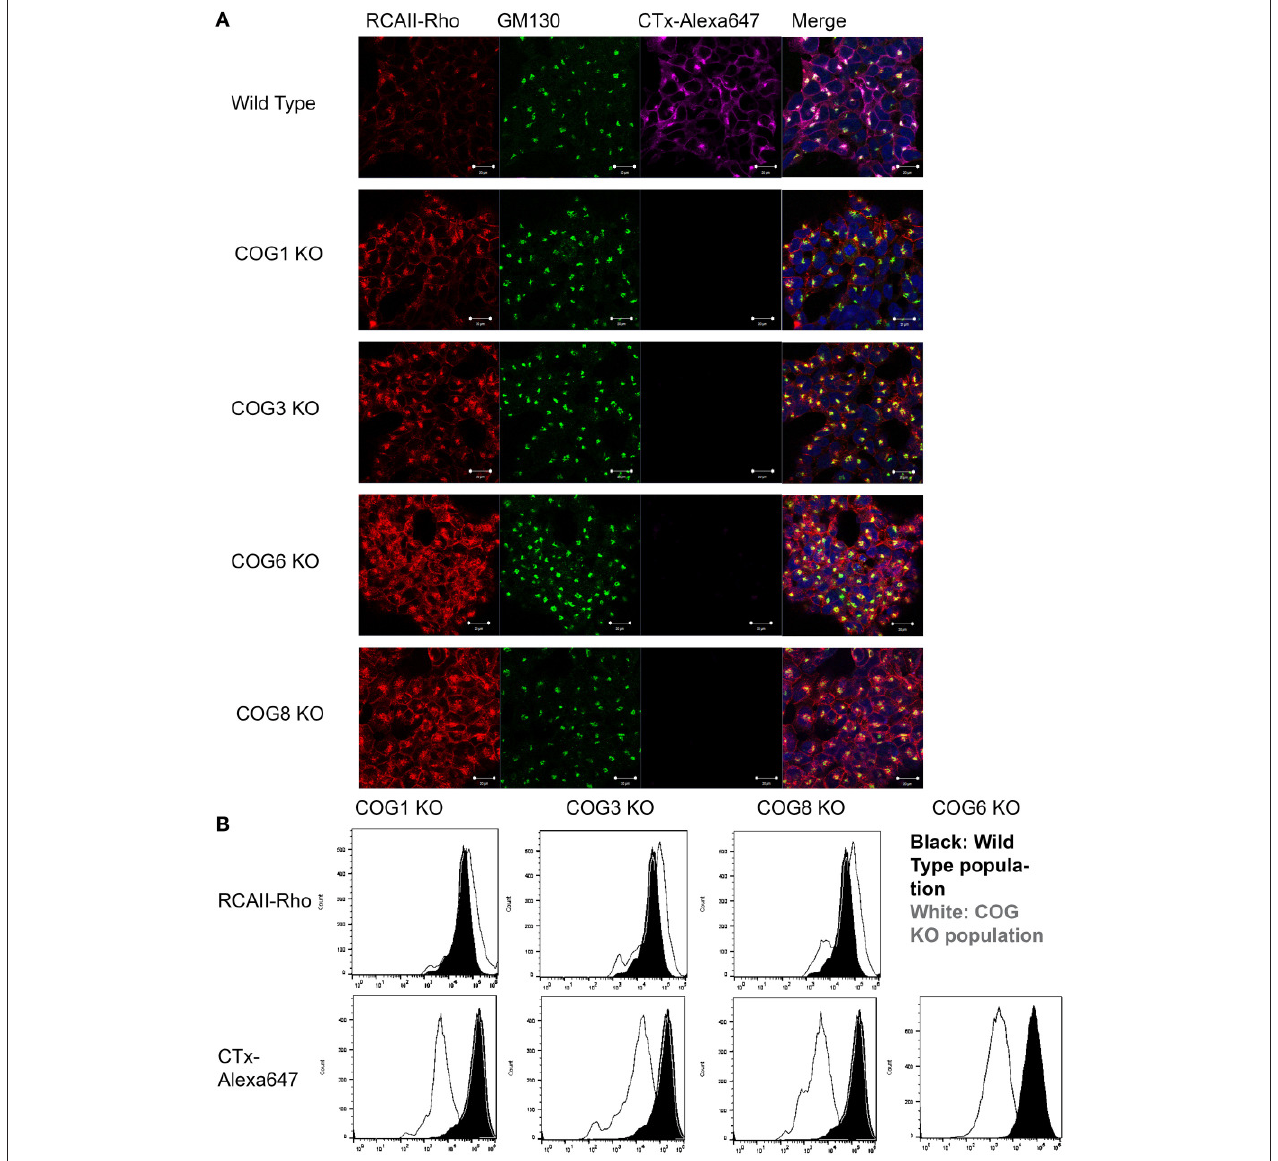
FIGURE 6 | COG KO cells are altered for the binding of RCA-I and CTxB to plasma membrane. (A) Pulse chase with labeled toxins was done at 37 ◦ C for 30 min before fixing and staining with GM130 antibodies. Cells were mounted in DAPI containing media. Coverslips were analyzed using a confocal microscope. (B) Cells were incubated with the toxins on ice for 30 min then processed using a flow cytometer and analyzed in